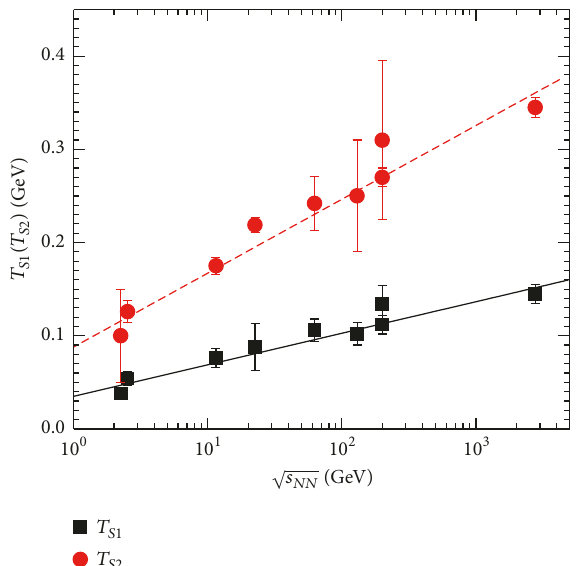
Figure 5: Dependence of 𝑇 𝑆1 (squares) and 𝑇 𝑆2 (circles) on √𝑠 𝑁𝑁 . The symbols represent the values of parameters taken from Table 1, and the error bars represent the statistical errors. The lines are the results fitted by the linear functions 𝑇 𝑆1,𝑆2 = 𝑎 ln √𝑠 𝑁𝑁 + 𝑏 .